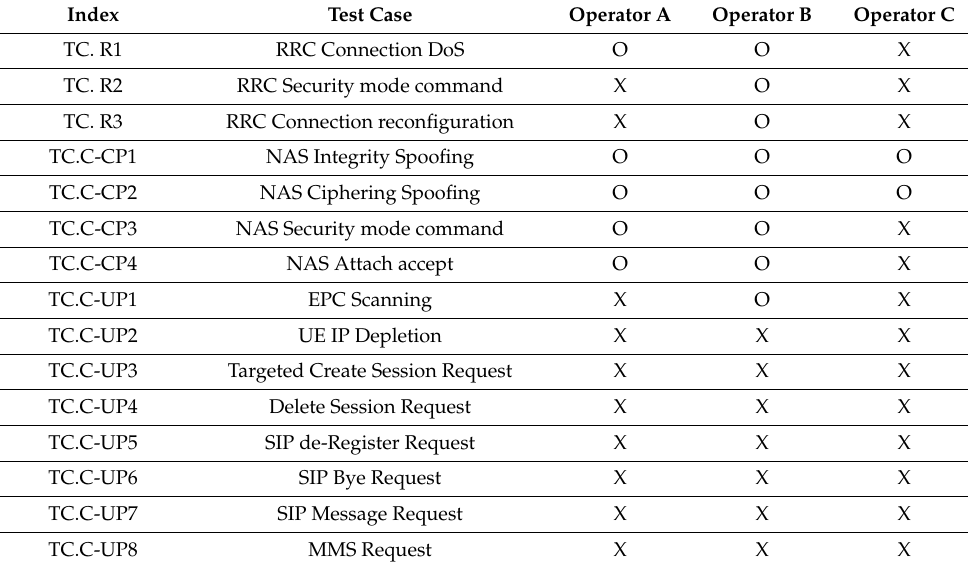
Table 7. Test result and vulnerability disclosure.